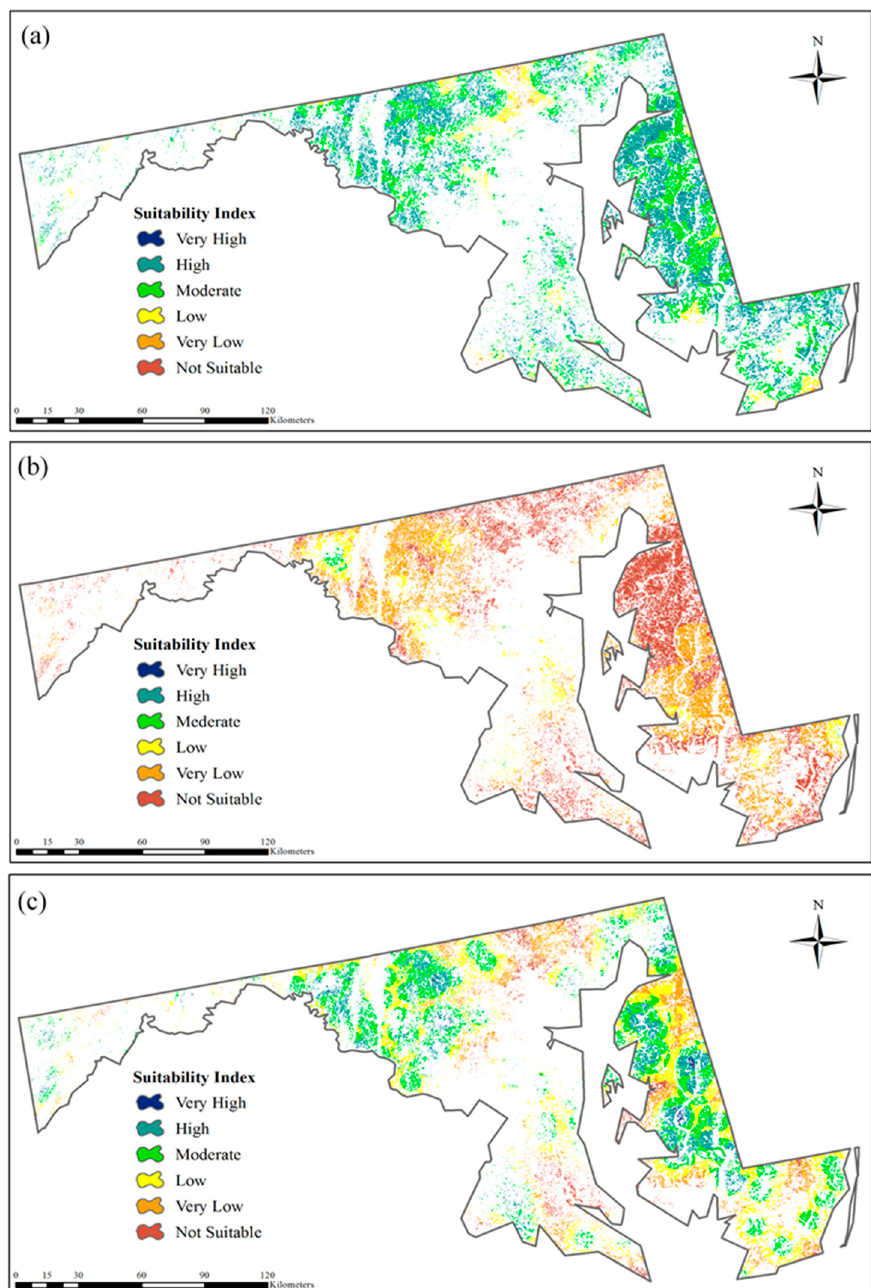
Figure 6. Suitability Map for three cases: ( a ) Case 1: considering selected discharging methods, ( b ) Case 2: considering potential discharge capacity, and ( c ) Case 3: considering appropriate treatment process.